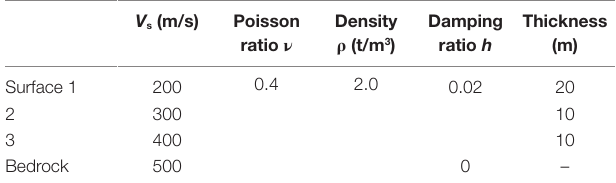
FigUre 5 | analysis model for sh problem . TaBle 2 | Property of soil.